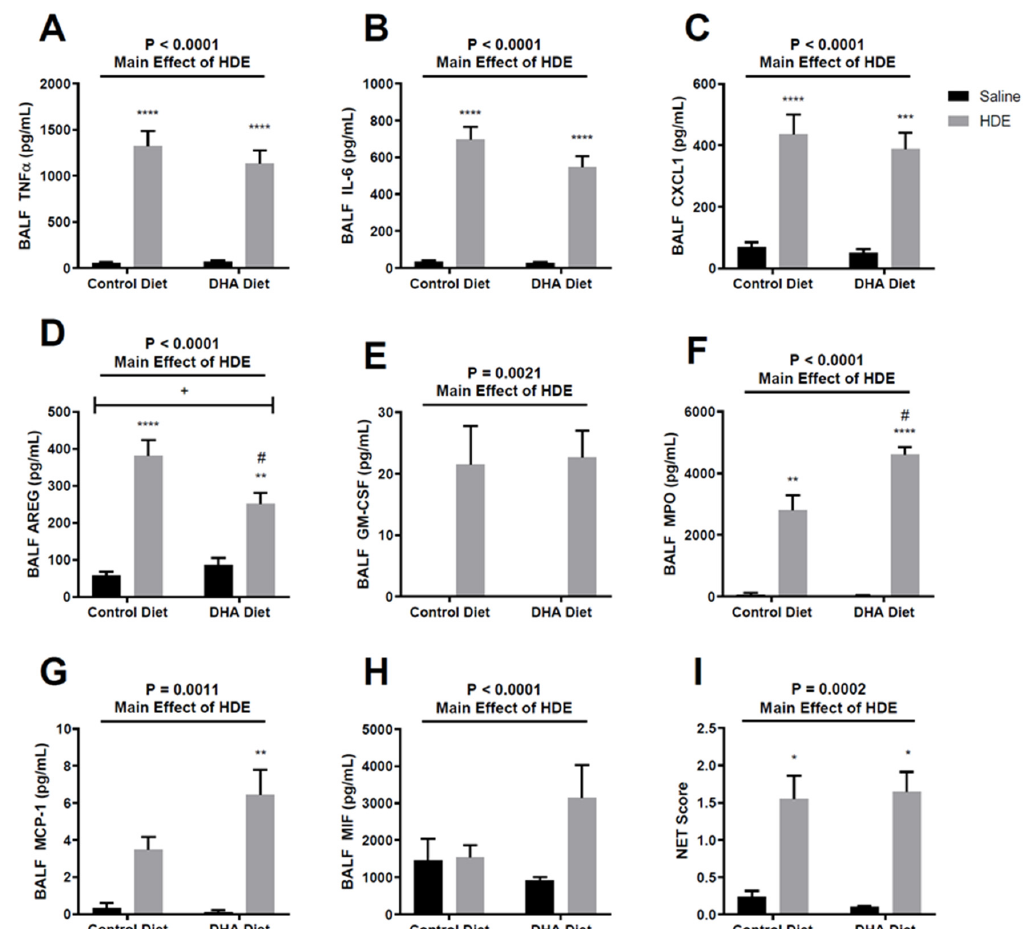
Figure 3. Effects of a DHA-rich diet on inflammatory mediator release and neutrophil extracellular trap (NET) formation following acute exposure to HDE. ( A – H ) BALF was collected from mice and screened for various cytokines and chemokines via ELISAs. ( I ) NET formation was assessed by scoring the BALF cytospins across all three experimental trials. The top line represents the main effect of HDE vs. saline with significance represented by p -values. Tukey post hoc comparisons are provided for DHA- vs. control-diet-treated conditions and are annotated by the # symbol (# p < 0.05). Significant di ff erences between HDE- and saline-treated conditions within diet groups are represented by the * symbol above the HDE bars (* p < 0.05; ** p < 0.01; *** p < 0.001; **** p < 0.0001). Any significant interactions between diet and exposure are depicted by the + symbol ( + p <